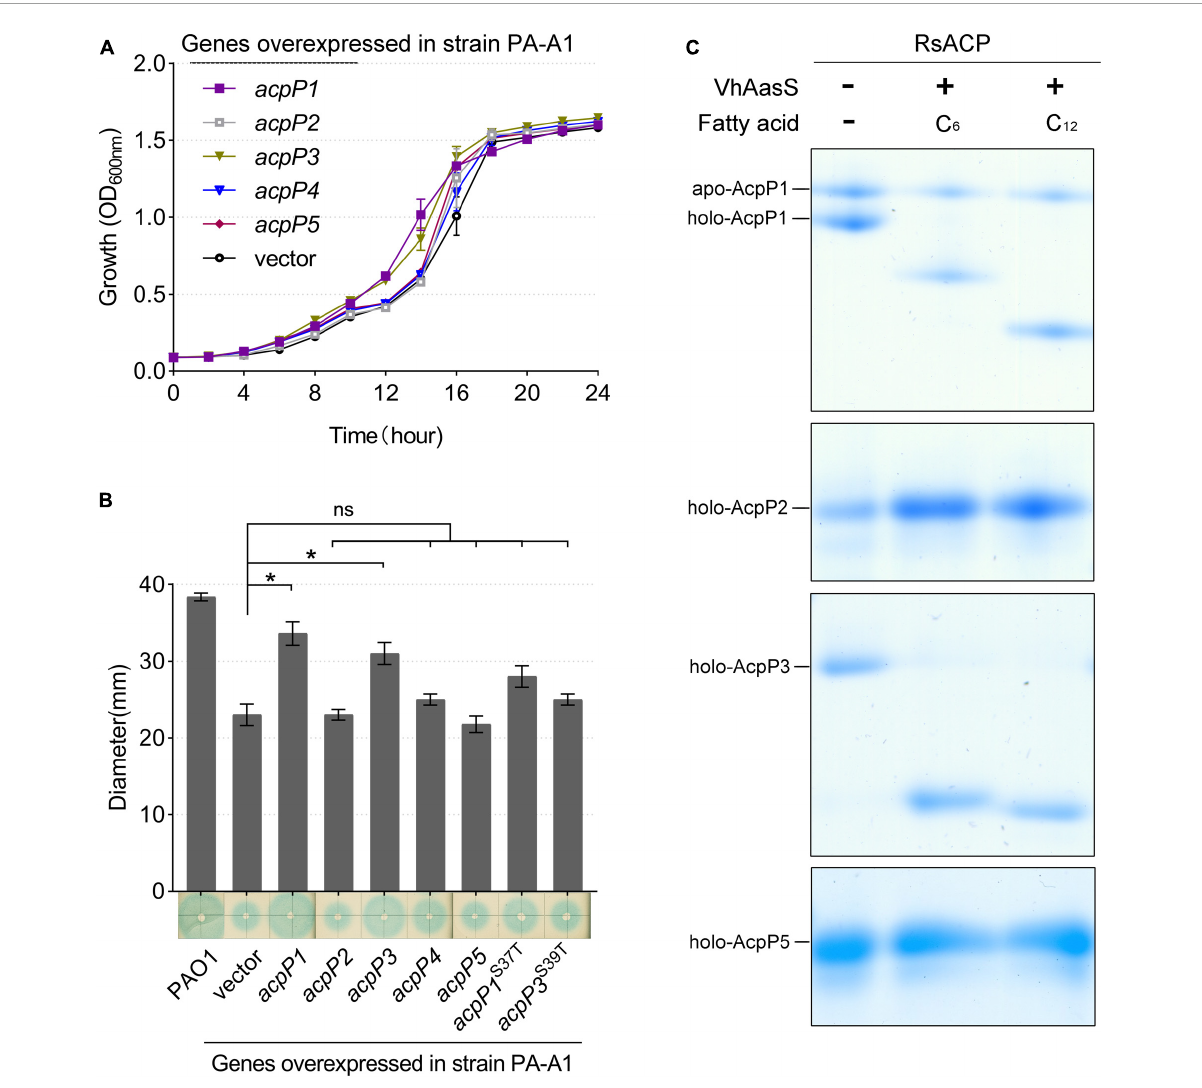
FIGURE5 Identification of R . solanacearum AcpPs in vivo and in vitro . (A) Growth of P. aeruginosa acpP1 -mutant strain PA-A1 harboring the R. solanacearum acp genes. Overexpression of R . solanacearum acp genes did not affect strain growth. (B) Detection of 3-oxo-C 12 -HSL signals produced by the complementation of strain PA-A1. The QS signal molecules were extracted as described previously and were dotted onto a ME medium plate that was supplemented with X-Gal and IPTG and covered with fresh A . tumefaciens NT1 ( traR , tra :: lacZ749 ; Guo et al., 2018). Student’s t -test was used to analyze the difference between PA-A1 carrying the empty vector and PA-A1 overexpressing the acp genes. *Indicates significant difference ( P < 0.05). ns Indicates no significant difference ( P > 0.05). (C) The R . solanacearum holo -AcpPs were acylated by VhAasS in vitro . The reaction mixtures contained holo -ACP, ATP, hexanoic acid or dodecanoic acid, and V. harveyi